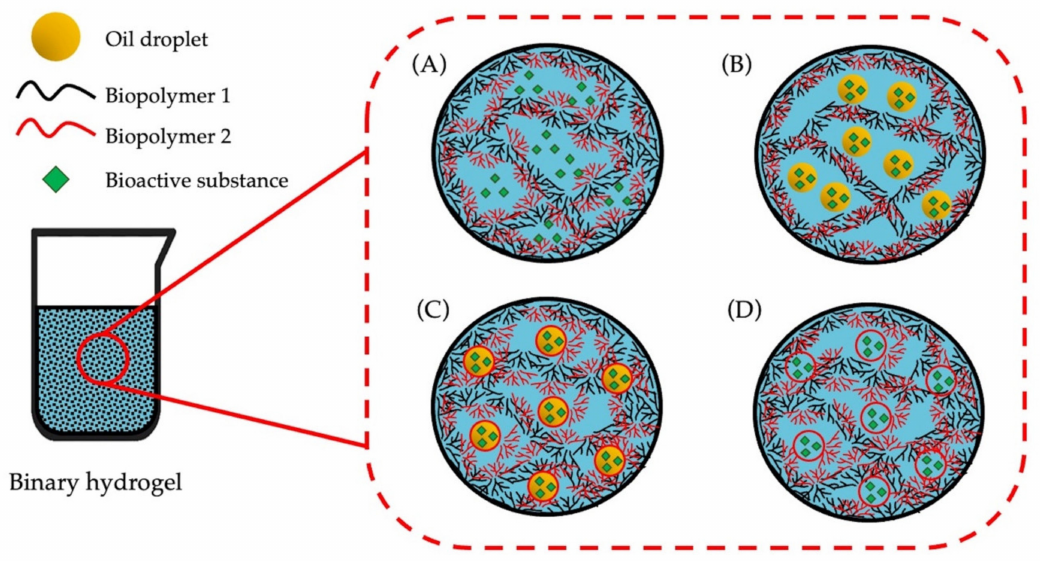
Figure 8. Schematic representation of the way in which bioactive substances can be embedded into a hydrogel matrix. ( A ) The hydrophilic bioactive substance is an inactive filler; ( B ) the hydrophobic bioactive substance is encapsulated in oil droplets and the oil droplets are inactive fillers. ( C ) the hydrophobic bioactive substance is encapsulated in oil droplets and the oil droplets are active fillers; ( D ) the hydrophilic bioactive substance is an active filler; Based on Farjami et al. [172], Liu et al. [41] and Li et al.